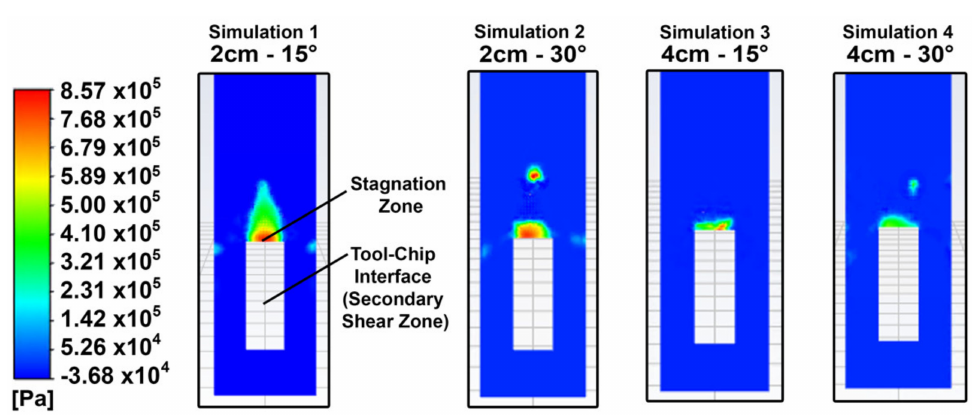
Figure 9. Static pressure at the cross section of the tool–chip interface (in Pa).